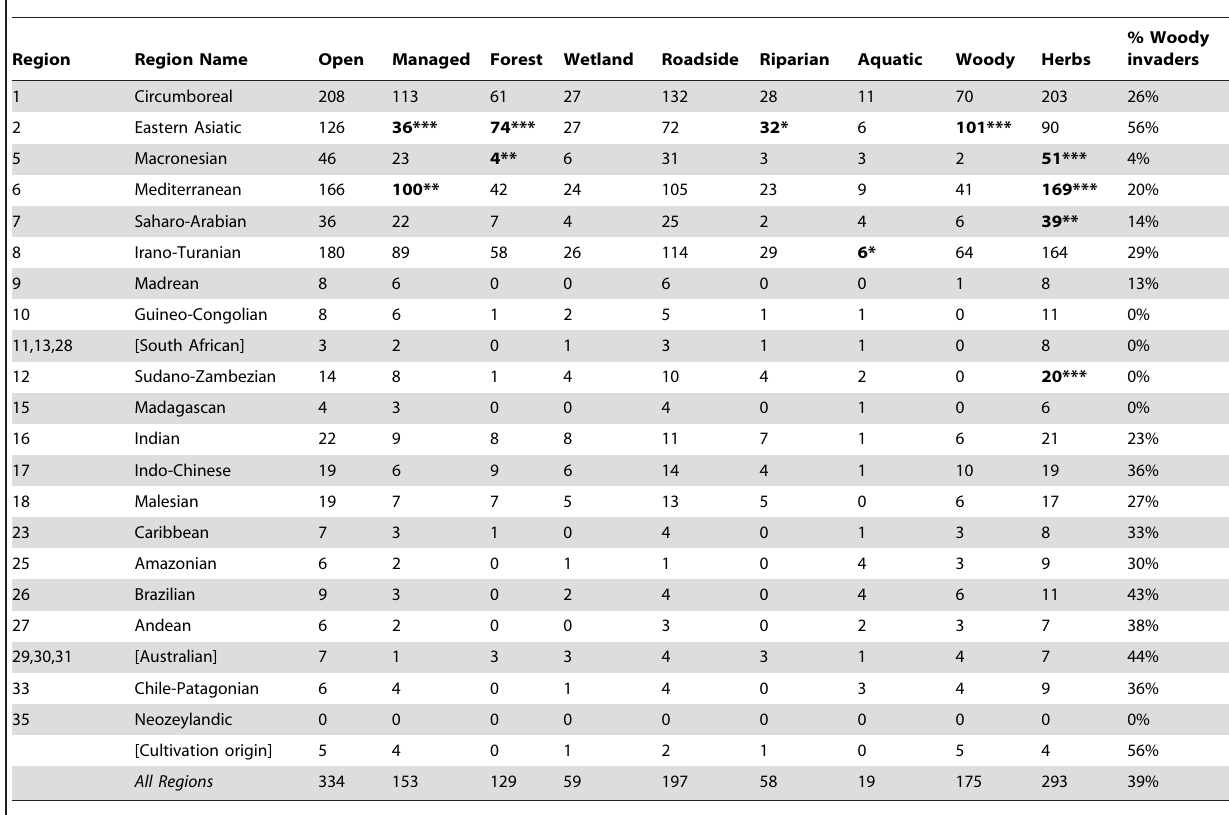
Floristic regions refer to Fig. 1. Bold counts are statistically significant outliers in Pearson chi-square analysis with significance level indicated by asterisks (overall habitat x region x 2 =243.6 on 120 df; P , 0.001; growth-form x region x 2 =104.1 on 20 df; P , 0.001). *P , 0.05; **P , 0.01; ***P ,